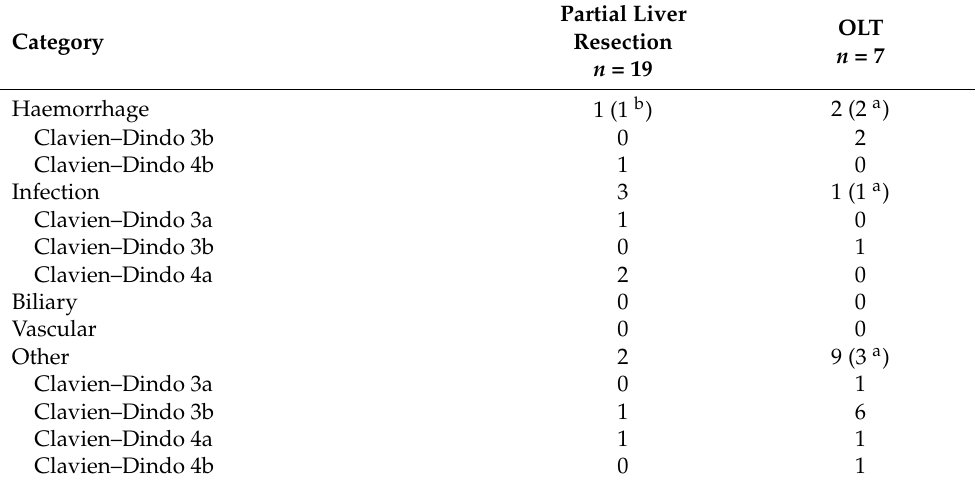
Table 3. Distribution of complications by severity (CD